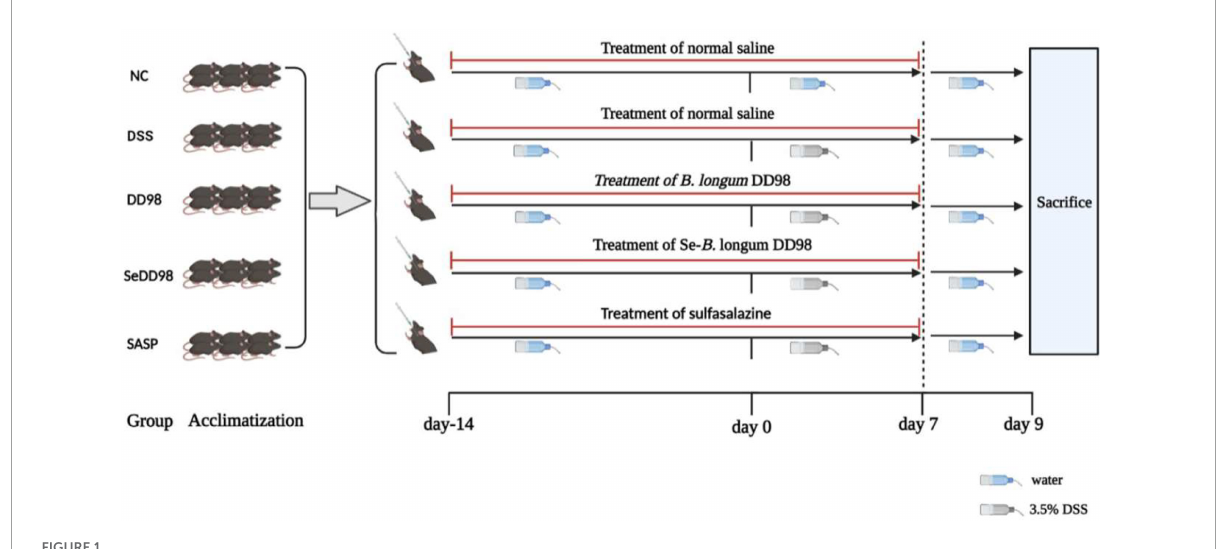
FIGURE1 Scheme of the animal experimental